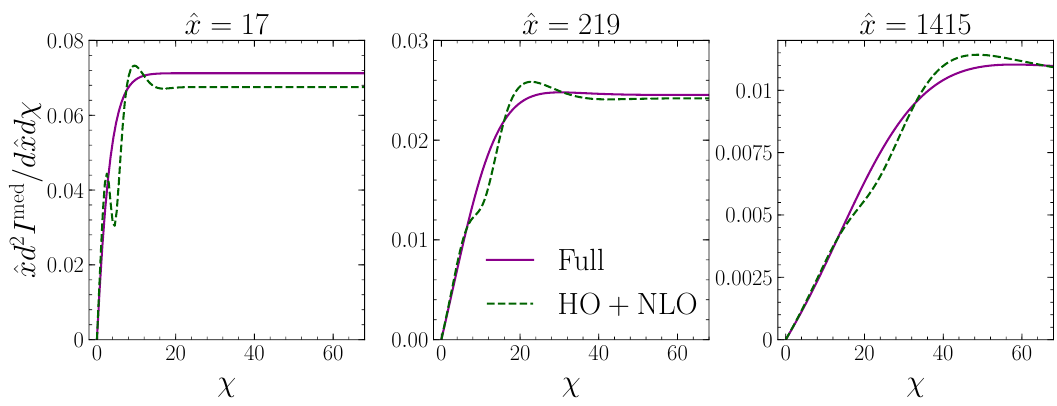
Figure 5 . Emission rates for the all-order evaluation (magenta solid lines) and the HO+NLO (green dashed) approximation as a function of χ for different values of ˆ x = ω/ω BH